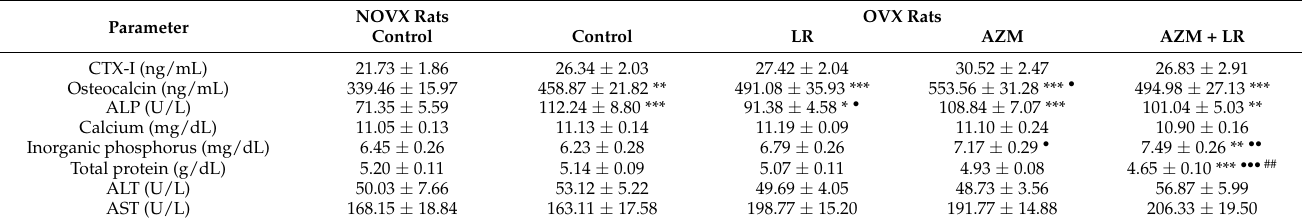
Table 1. Effect of azithromycin (AZM) and/or Lactobacillus rhamnosus (LR) on serum biochemical parameters in ovariectomized rats.